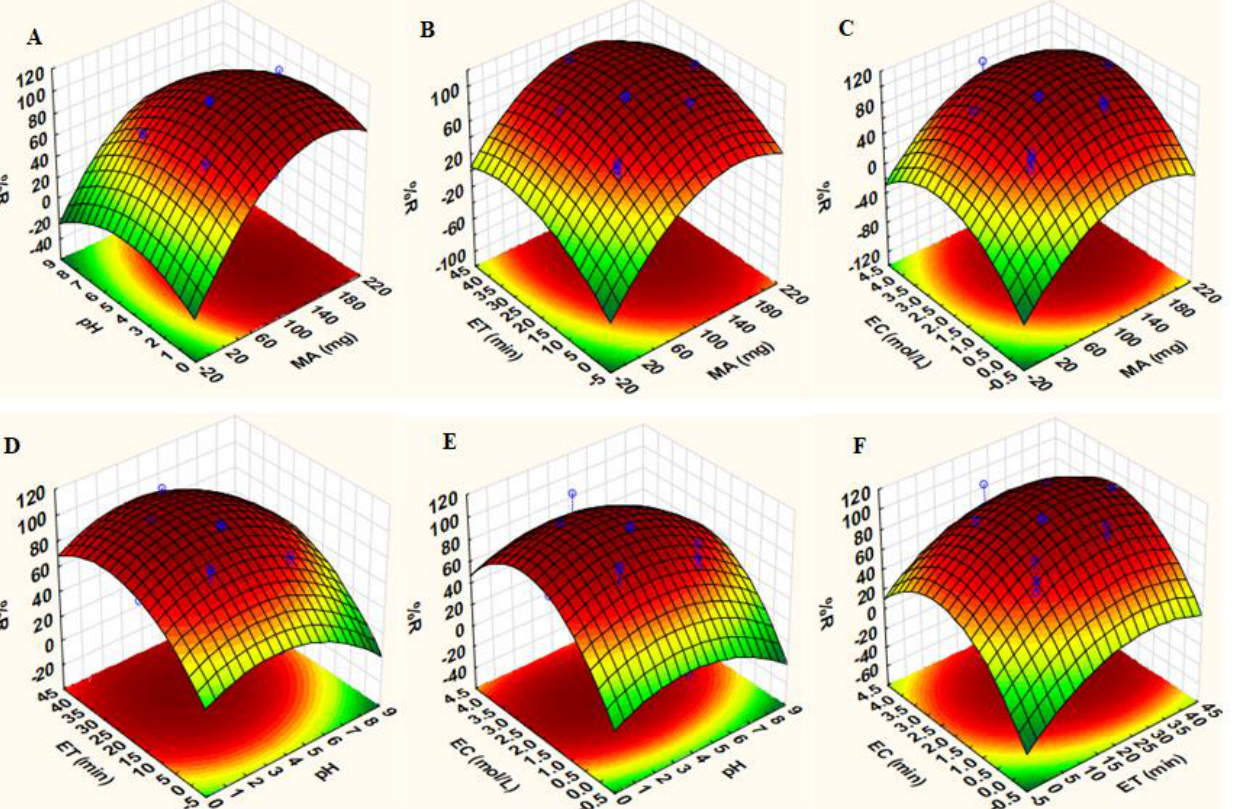
Figure 10. 3D response surface plots of precious elements: Interactions between: ( A ) sample pH and mass of adsorbent (MA) while fixing extraction time (ET) and eluent concentration (EC) at central points, ( B ) ET and MA while fixing pH and EC at central points, ( C ) EC and MA while fixing pH and ET at central points, ( D ) ET and pH while fixing MA and EC at central points, ( E ) EC and pH while fixing MA and ET at central points, ( F ) ET and EC while fixing pH and MA at central points (Table 1).